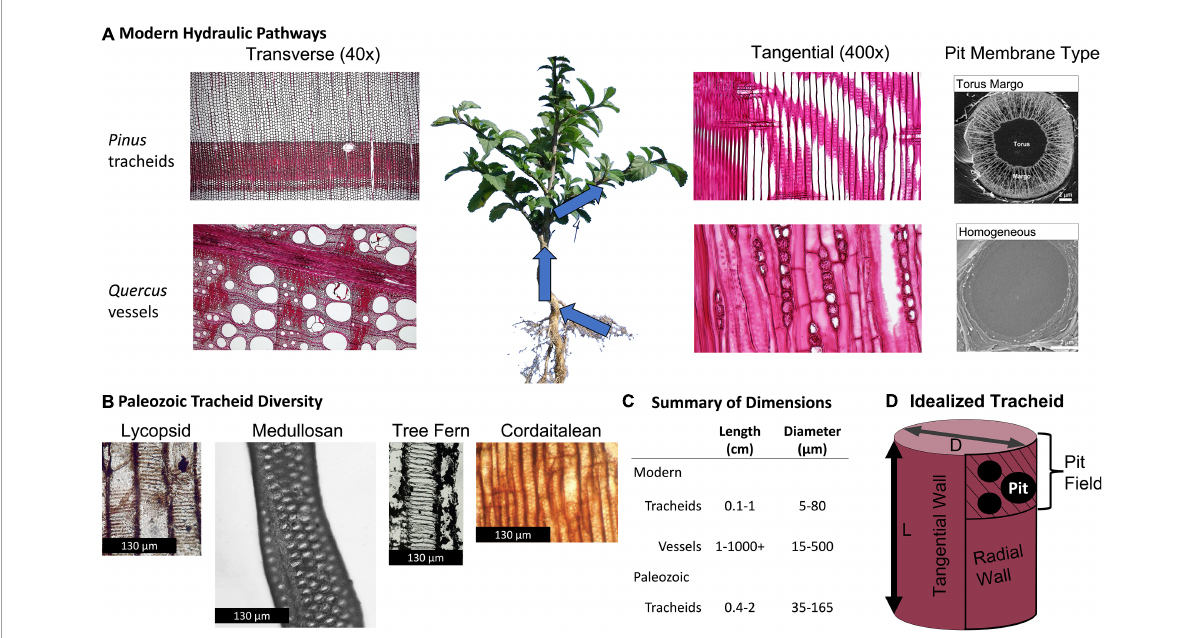
FIGURE1 Vascular plant hydraulic pathway conducting element features. (A) Conducting elements (tracheids or vessels) form a network that allows water transport from the roots, through the stem and branches, and to the leaves. Modern plant vascular trait combinations typically follow one of three syndromes. Conifers contain tracheids connected by torus-margo pits ( A , top row), angiosperms contain vessels connected by homogeneous pit membranes ( A , bottom row), and seed-free vascular plants contain tracheids and homogeneous pit membranes (not pictured). Paleozoic plants typically contained tracheids (B) , which were large compared to modern conifers and ferns (C) , connected by homogeneous pit membranes. For the model presented here we consider an idealized tracheid (D) of length L and diameter D with surface area A t = 2 π r (r + h). In the model tracheid, radial walls (one pictured), are half covered by pit-field (hatched) and half lacking pits, whereas tangential walls are entirely lacking pits. Modern light photomicrographs are from Reynolds (2014), and SEM from Venturas et al. (2017). Paleozoic tracheid micrographs are from Morgan (1930), Wilson et al. (2008), Wilson (2013), and Viney et al. (2019), dimensions are summarized from Pittermann et al. (2006), Hacke et al. (2007), and Brodersen et al.